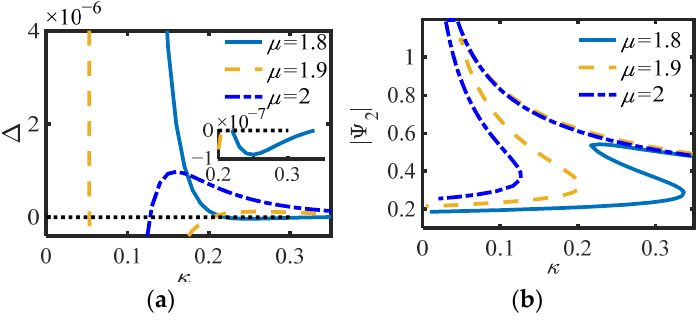
Figure 8. ( a ) Δ and ( b )| Ψ 2 | of S.1 vs. κ for different μ ( m 2 = 4). In S.2, the parameters of Figure 6b ( m 2 = 0, c s = 0.3, b n = 0.4, c n = 0.002) and Figure 6c ( m 2 = 0, c s = 0.1, b n = 0.4, c n = 0.002) in the previous section are selected, and the curves of (a) Δ (Equation (26)) and (b) | Ψ 2 | of S.2 versus κ for different μ are drawn, as shown in Figures 9 and 10.